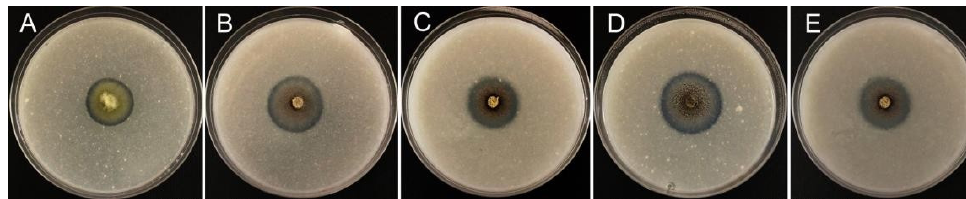
Figure 1. Phosphate solubilization assays of five isolates on the modified NBRI-MTSB media. ( A ) HZ06. ( B ) HZ23. ( C ) HZ10. ( D ) HZ123. ( E ) HZ22.